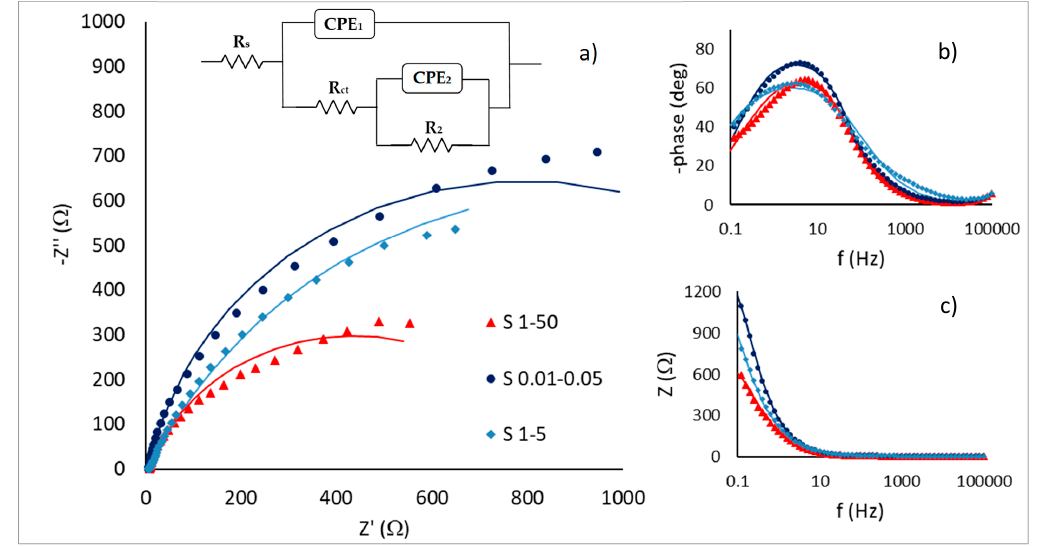
Figure 4. Nyquist diagram ( a ), Bode phase ( b ) and Bode modulus ( c ) recorded in KOH 1 M at open circuit potential. Inset: equivalent circuit used to model the EIS spectra.